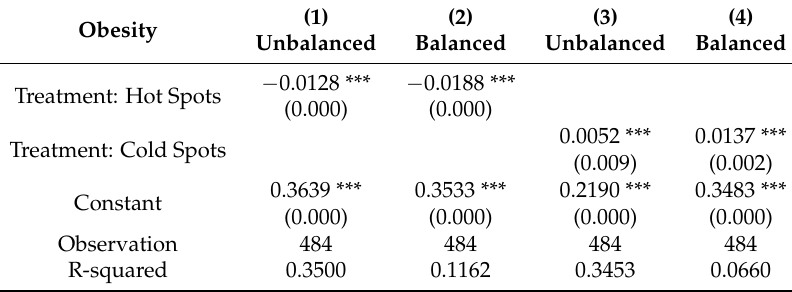
Table A4. The impacts of hot and cold spots on obesity rates.